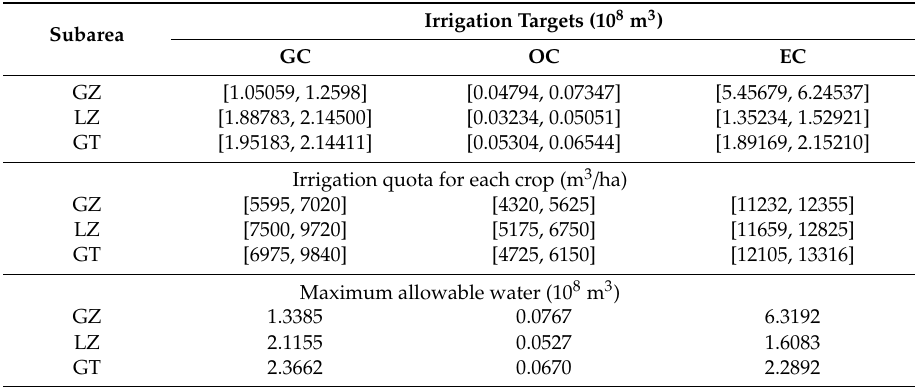
Table 2. Irrigation targets, irrigation quota and the maximum allowable water.